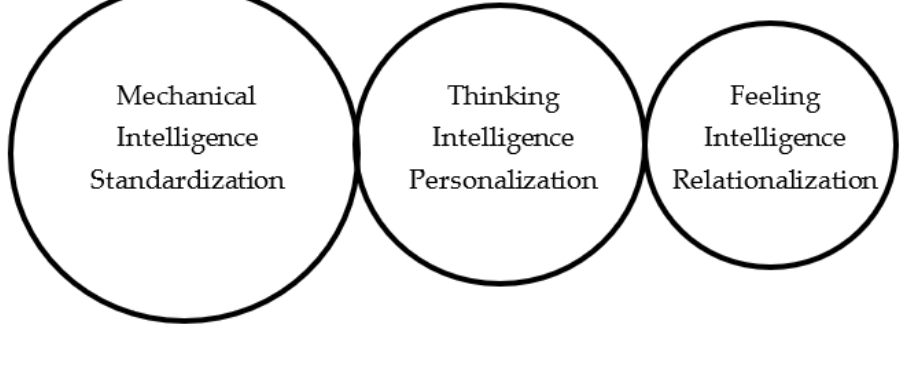
Figure 1. Three artificial intelligences (Adapted from Huang and Rust [26]). Mechanical artificial intelligence is used for simple, standardized, repetitive, and routine tasks. An example of a civil application of mechanical intelligence is the use of service robots to clean hotel rooms, replacing humans in routine and standardized tasks [18]. Thinking artificial intelligence is used for complex, systematic, rule-based, and well-defined tasks. An example of this is Boston Dynamics’ quadrupedal robots, highly adaptable, versatile, and capable of capturing the mobility, autonomy, and speed of living creatures [31,32]. Feeling artificial intelligence is used for social, emotional,